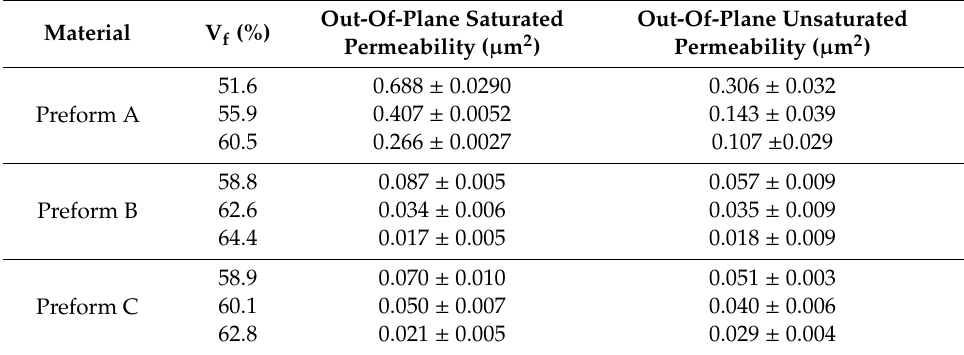
Table 2. Out-of-plane saturated and unsaturated permeabilities for the investigated preforms. Out-Of-Plane Saturated Material V f (%) Permeability ( µ m 2